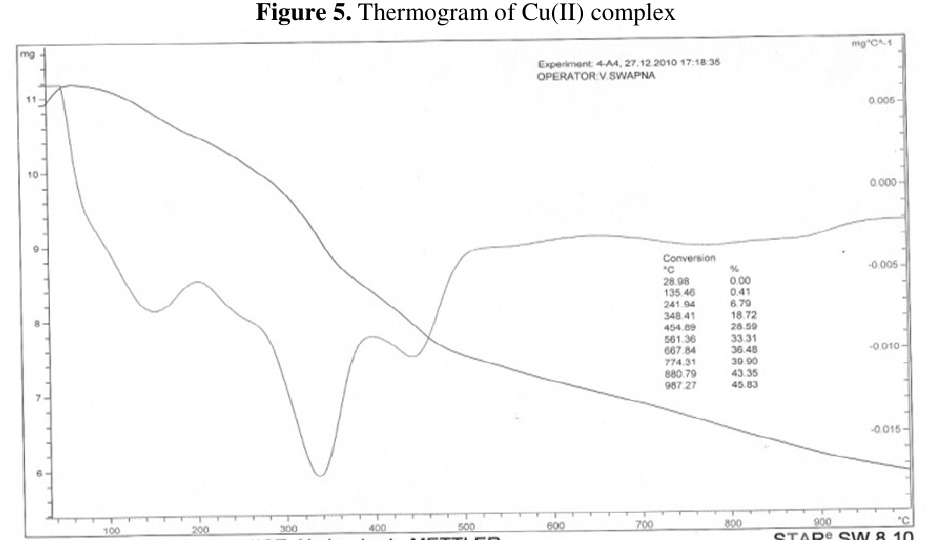
Figure 5. Thermogram of Cu(II) complex